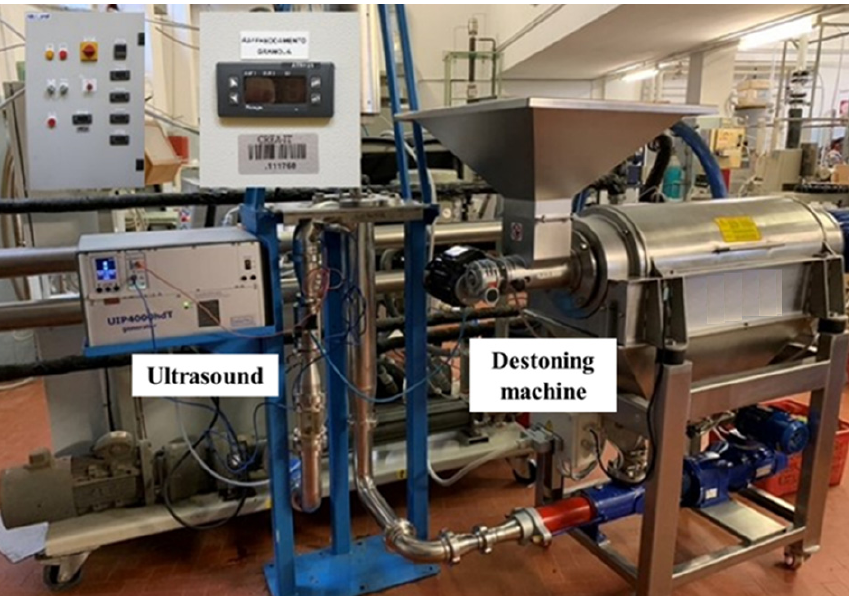
Figure 1. The experimental system consists of the ultrasound and destoning machine, used for the tests at the Department of Agricultural, Food, and Environmental Sciences of the University of Perugia (Italy).